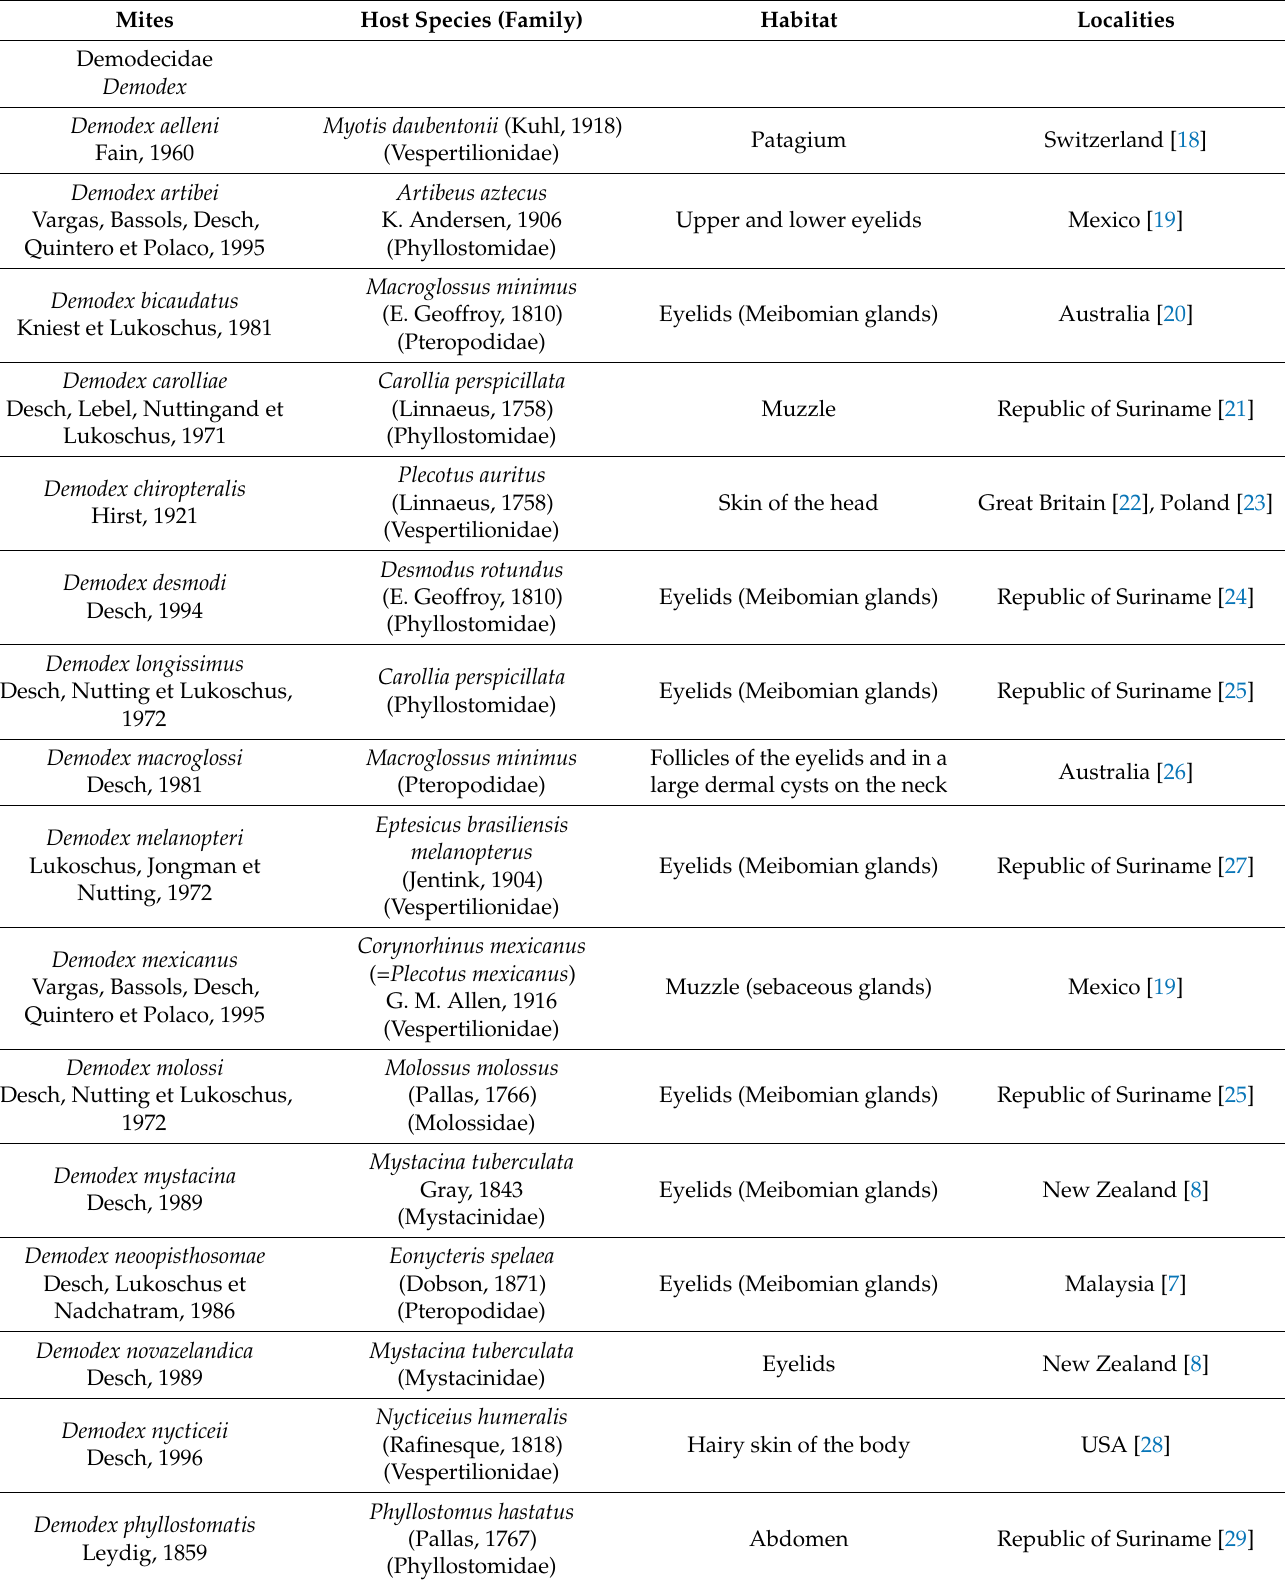
Table 4. A checklist of skin mites in the Demodecidae and Psorergatidae families reported in